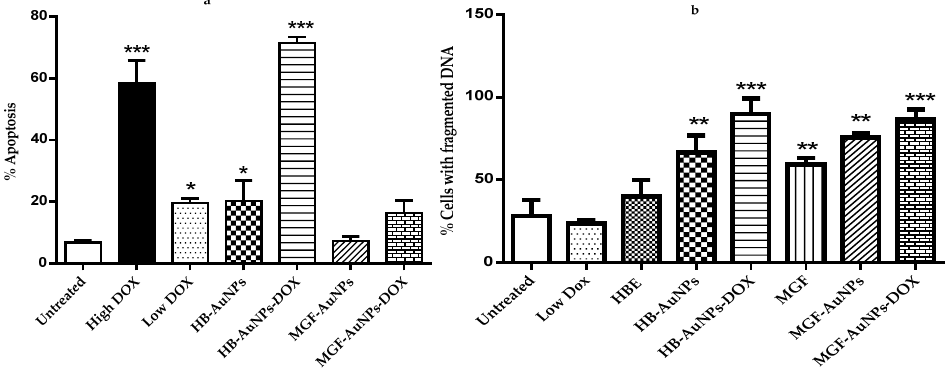
Figure 5. Effect of treatments on apoptosis and DNA fragmentation. Cells were treated with Low DOX (1.56 µg/mL), High DOX (7.8 µg/mL), HBE (1000 µg/mL), MGF (1000 µg/mL), MGF-AuNPs (1000 µg/mL), HB-AuNPs (1000 µg/mL), MGF-AuNPs-DOX (1000 µg/mL MGF-AuNPs and 1.56 µg/mL DOX) and HB-AuNPs-DOX (1000 µg/mL HB-AuNPs and 1.56 µg/mL DOX); ( a ) shows the